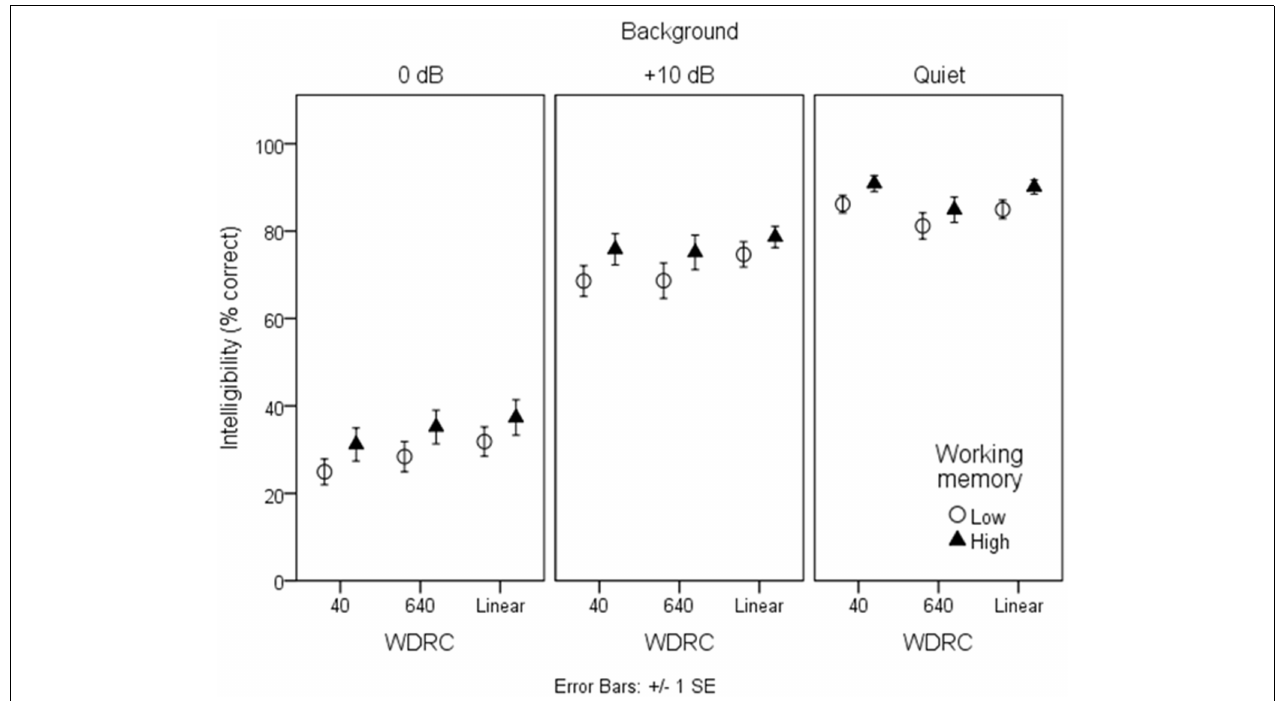
FIGURE 3 | Mean intelligibility for low- and high-working memory groups by WDRC condition. Error bars show ± one standard error about the mean.